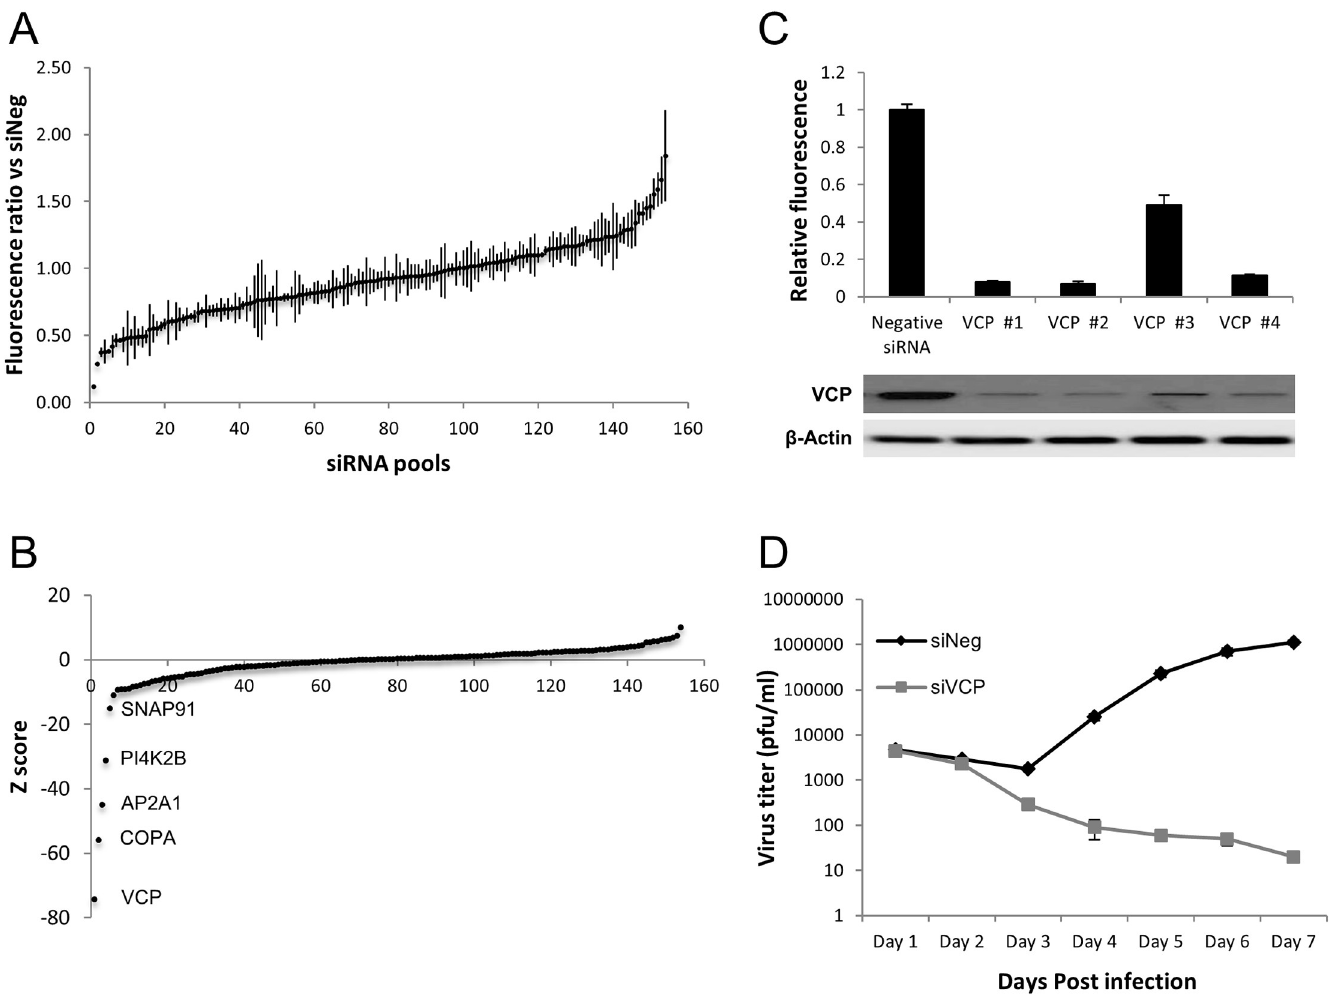
Fig 2. Knockdown of the cellular gene VCP results in a complete block in HCMV replication. Human primary fibroblast cells were transfected with 160 siRNA pools against membraneorganization genes then infected with a GFP expressingHCMV virus. (A) RelativeGFP fluorescence levels compared to cells transfected with a negative control siRNA for all 160 siRNA pools. Assays were performed in duplicatewith three biological repeats with standard deviations shown. (B) GFP levels rankedby Z-score. (C) VCP deconvoluted siRNAs were tested for VCP knockdown by western blot and virus replication by relativeGFP fluorescence to negativecontrol siRNA transfected cells. GFP levels were measured144 HPI and assays performed in duplicate. (D) HCMV replication was measuredby plaqueanalysisfollowingtransfectionwith VCP siRNA or negativecontrol siRNA. Cells were infected at an MOI of three and performed in duplicatewith two biological